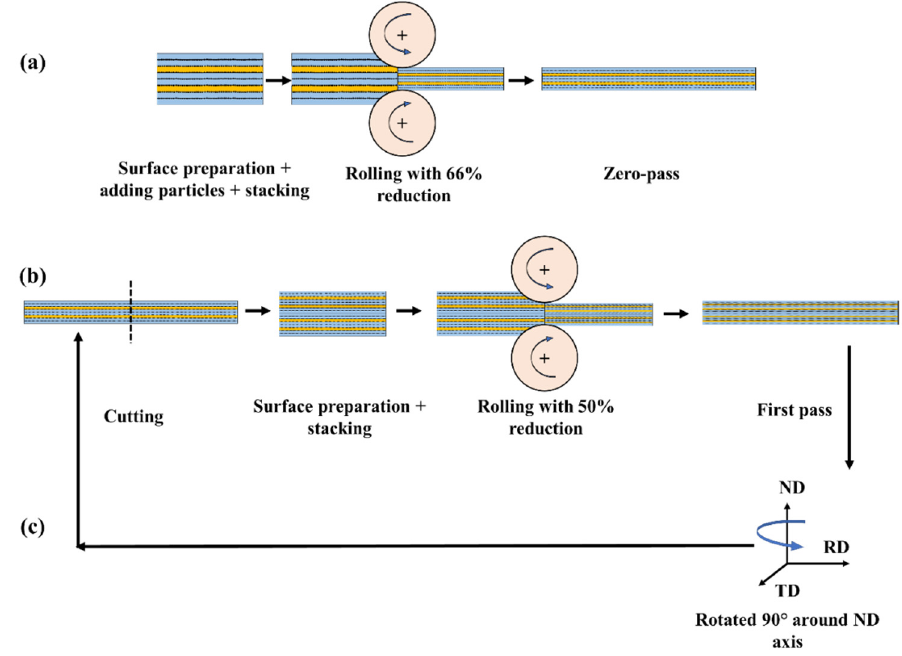
Figure 1. Schematic of ( a ) zero pass, ( b ) ARB and ( c ) CARB processes.